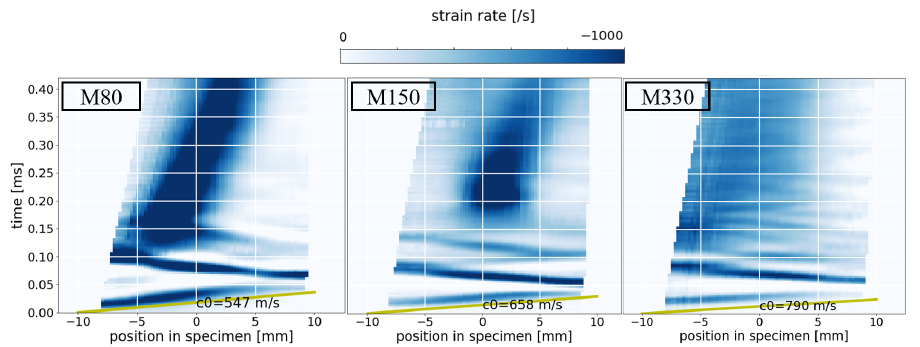
Figure 7: Lagrange plots of strain rate distribution in the foam specimens during dynamic compression at an average strain rate of 500 / s. Yellow lines at the bottom indicate the elastic speed of sound take from Table